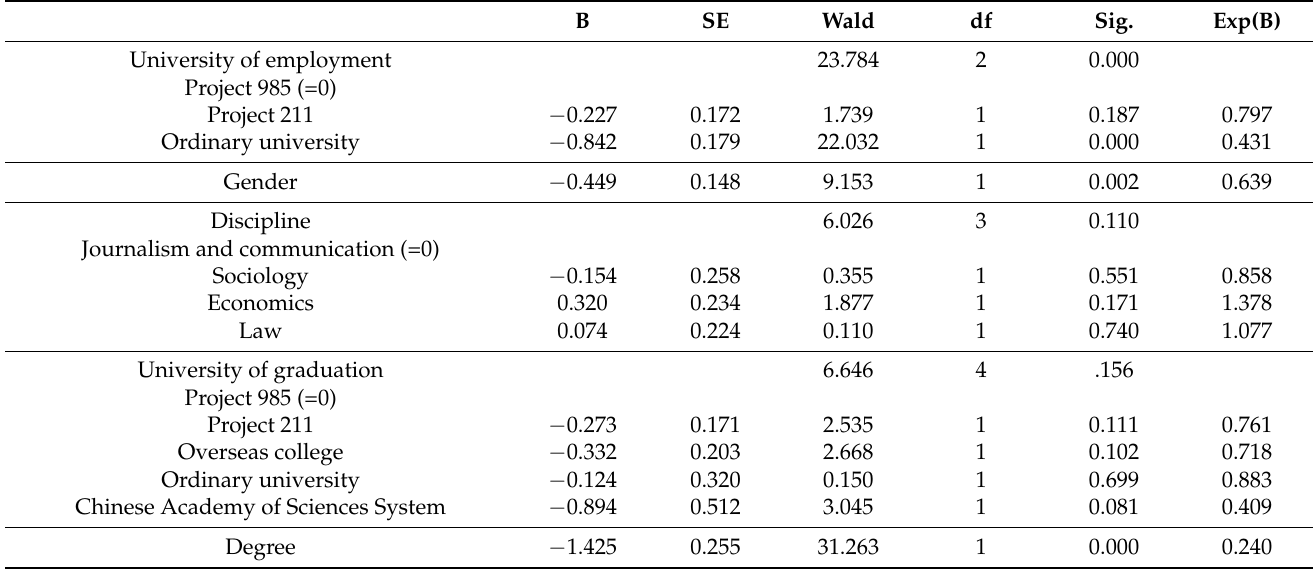
Table 4. Cox Model Results (Assistant to Associate Professor).